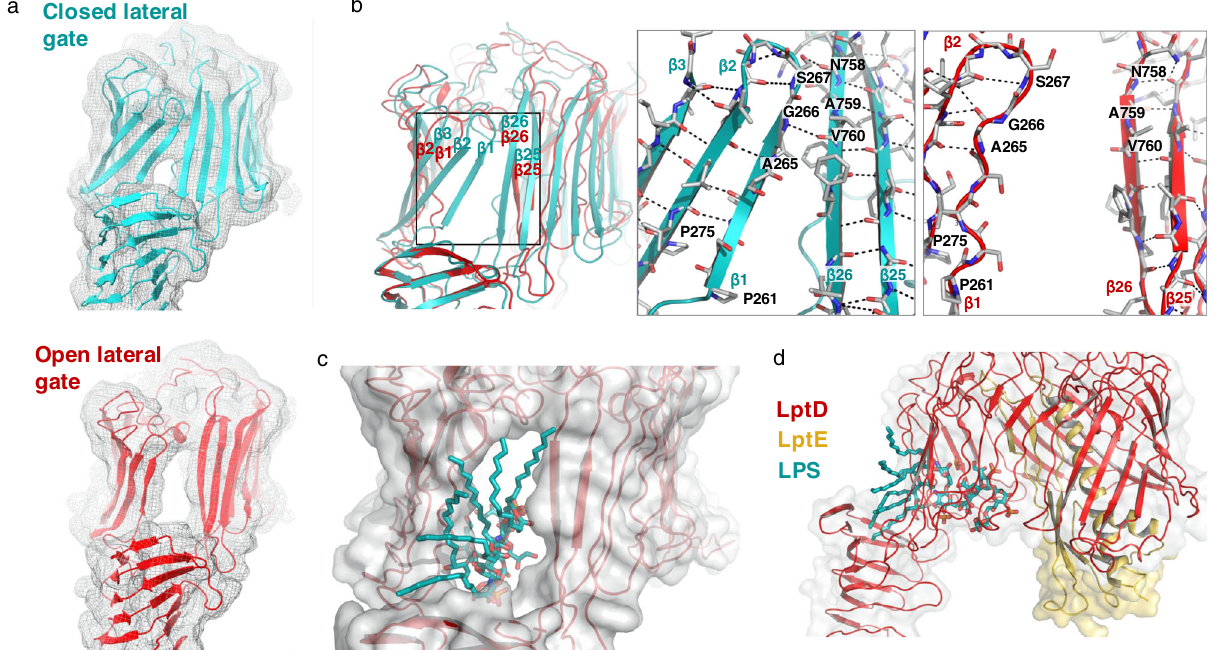
Fig. 5 Comparison of the closed and open lateral gate of NgLptD. a Cryo-EM density of the NgLptD structures with closed (top) and open lateral gate (bottom) (maps displayed to the comparable contour level) with the respective model shown in cyan and red for the partly and fully open NgLptDE, respectively, ( b ) Superimposed models of NgLptD in partly (cyan) and fully open conformations (red). The boxes show the hydrogen-bond networks at the terminal strands of partly open (cyan, left) and fully open (red, right). c An LPS molecule (cyan) (extracted from 3FXI without modi fi cations) fi tted into the laterally open NgLptDE (red/yellow) viewed from extracellular or from the side ( d